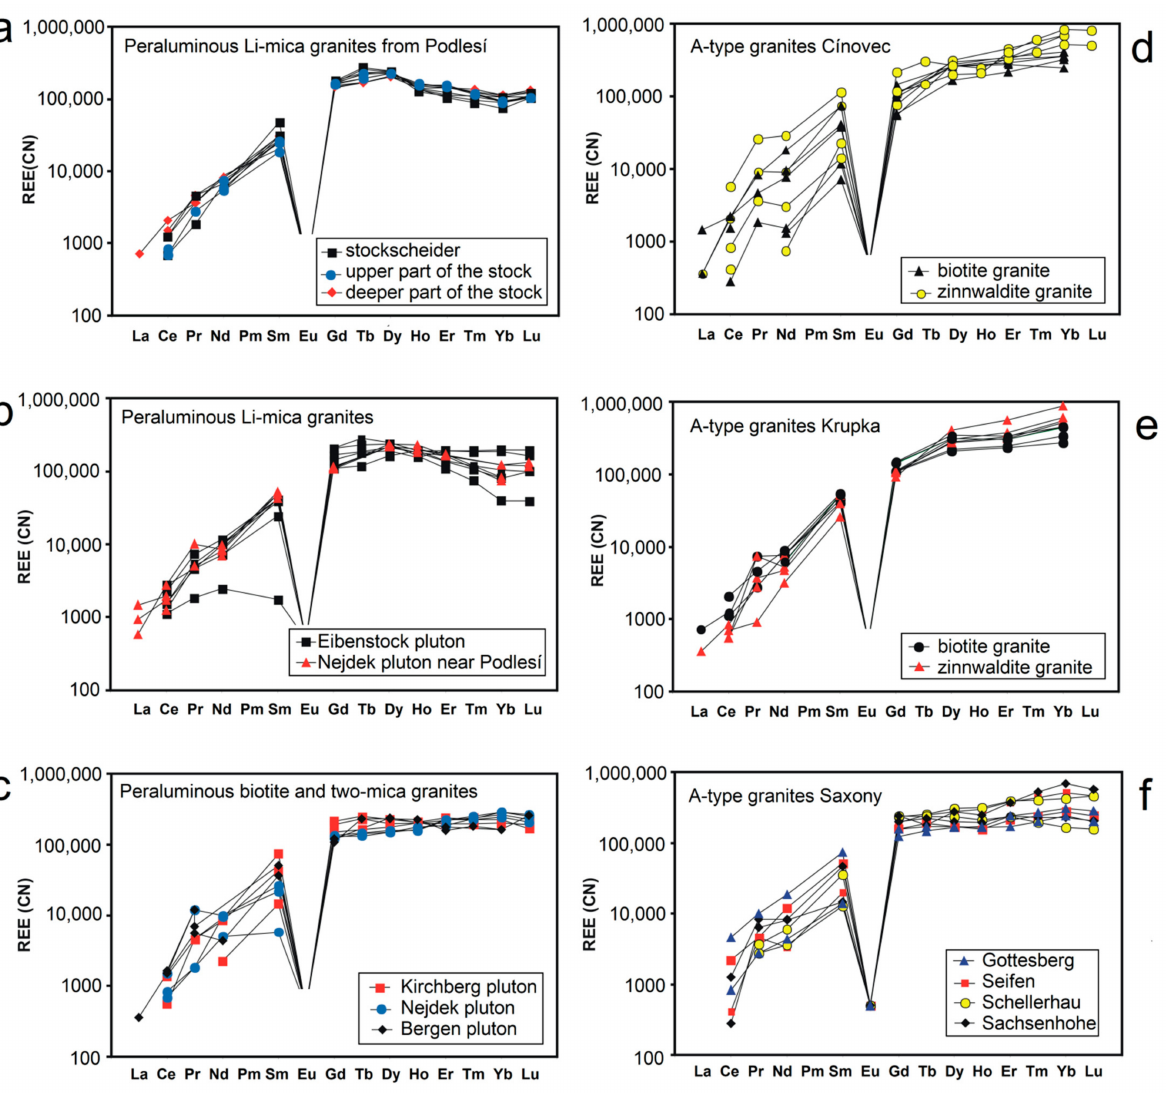
Figure 6. Chondrite-normalized [26] REE distribution patterns of xenotime from the Erzgebirge. ( a – c ) granites of the peraluminous suite; ( d – f ) granites of the